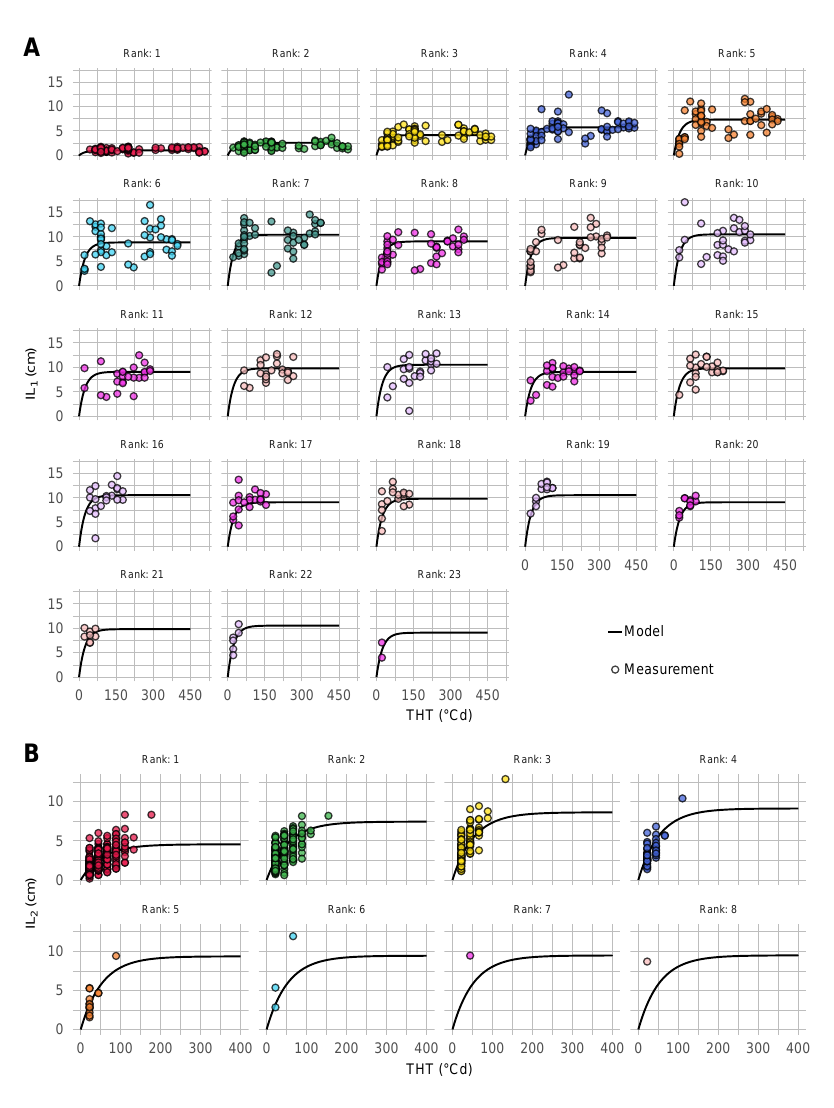
Figure 5. Model fit (solid line) and measurement data (circles) for internode length over thermal time: ( A ) internodes of primary shoots, where colours indicate different model coefficients, showing the repetitive pattern (equal colours) at ranks R > 7 (Equation (4)); and ( B ) internodes of lateral shoots, where colours indicate different model coefficients